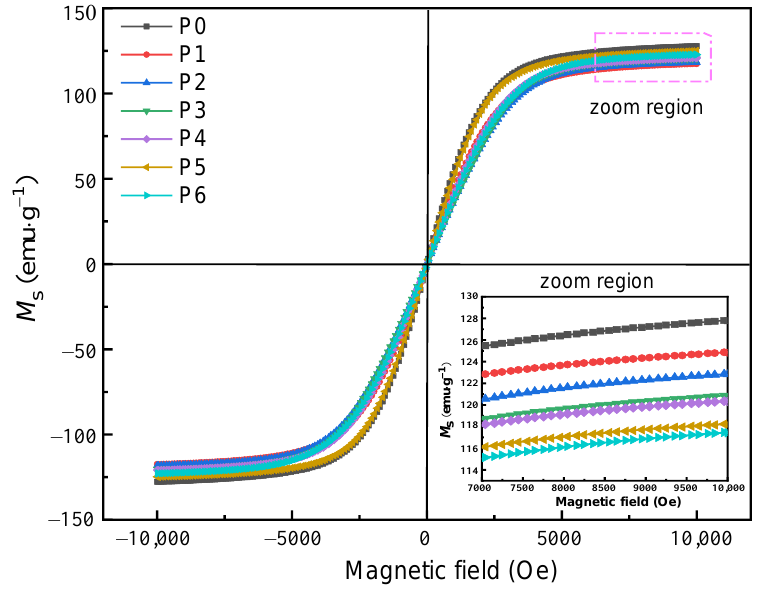
Figure 5. The hysteresis loops of powders